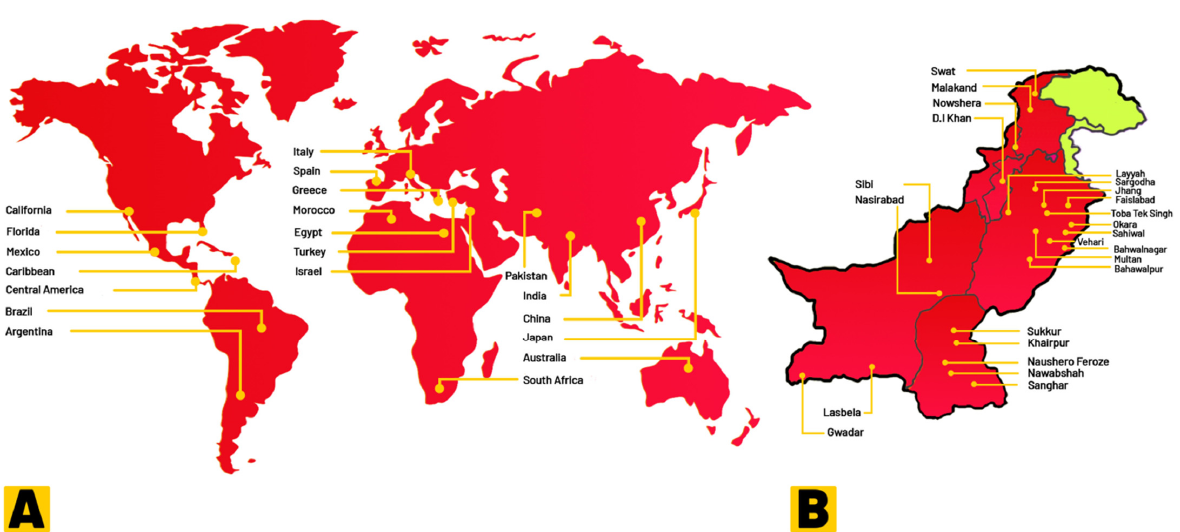
Figure 1. ( A ) World citrus production areas and ( B ) Pakistan’s various districts participating in world citrus production. In Pakistan, citrus fruit is predominantly cultivated in four provinces.